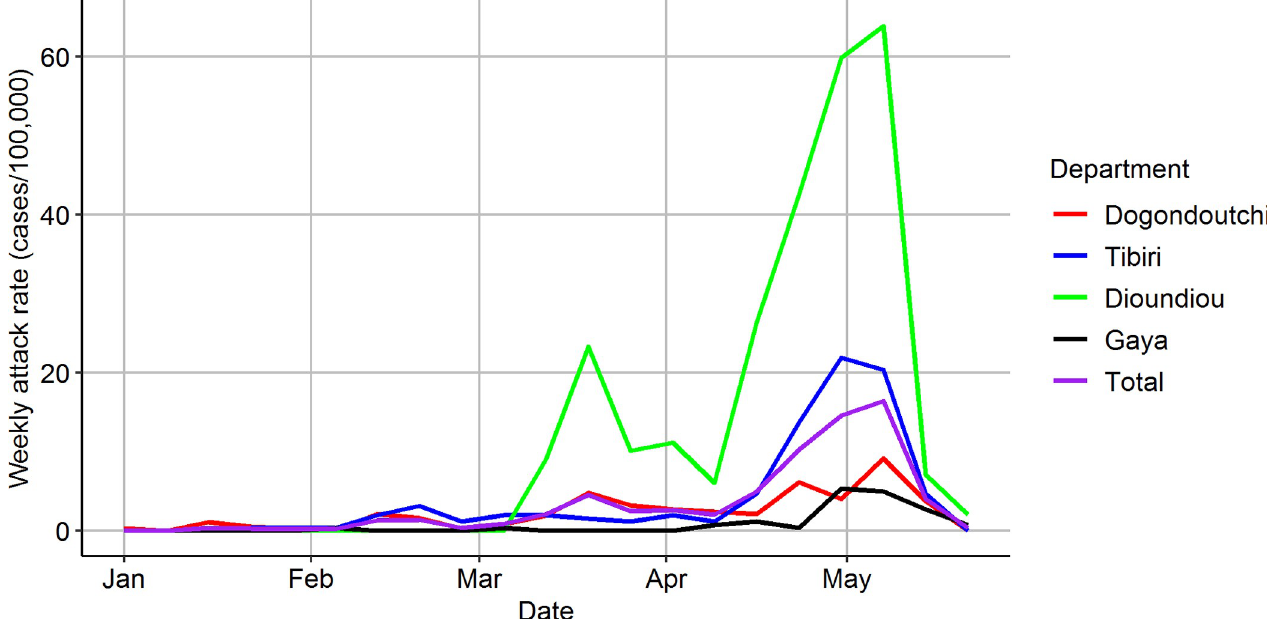
Fig 1. Epidemic curve in study area. Weekly attack rate of suspected meningitis in Dogondoutchi (red), Tibiri (blue), Dioundiou (green), Gaya (black), and in the whole study area